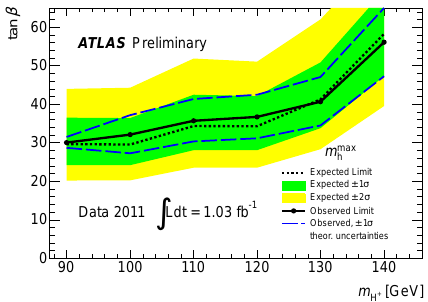
Fig. 7. Expected and observed combined upper limits of ( t H + b ) with 95% C.L. as a function of m H + . B →